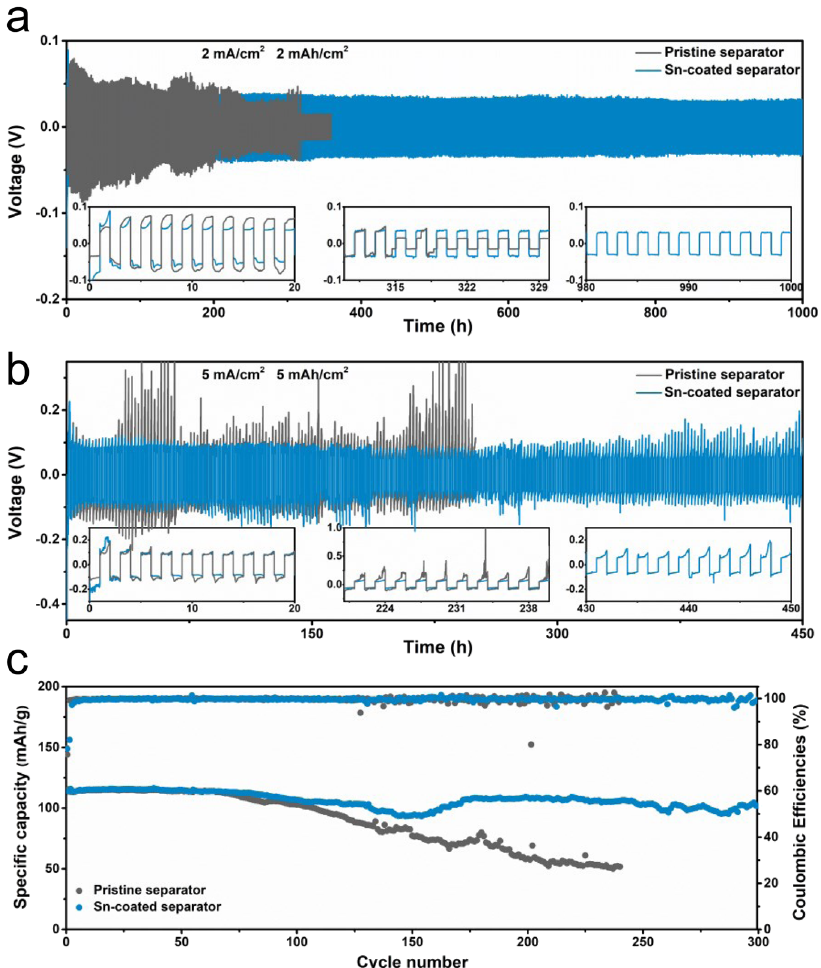
Fig. 6 The electrochemical performances of Na metal batteries. The cycling performances of Na/Na cells using pristine separator and Sn-coated separator are tested at a 2 mA/cm 2 and 2 mAh/cm 2 , b 5 mA/cm 2 and 5 mAh/cm 2 . c The cycling performances of Na||NVPF batteries using pristine separator and Sn-coated separator at 0.1 A/g, with N : P ratios of 5 :